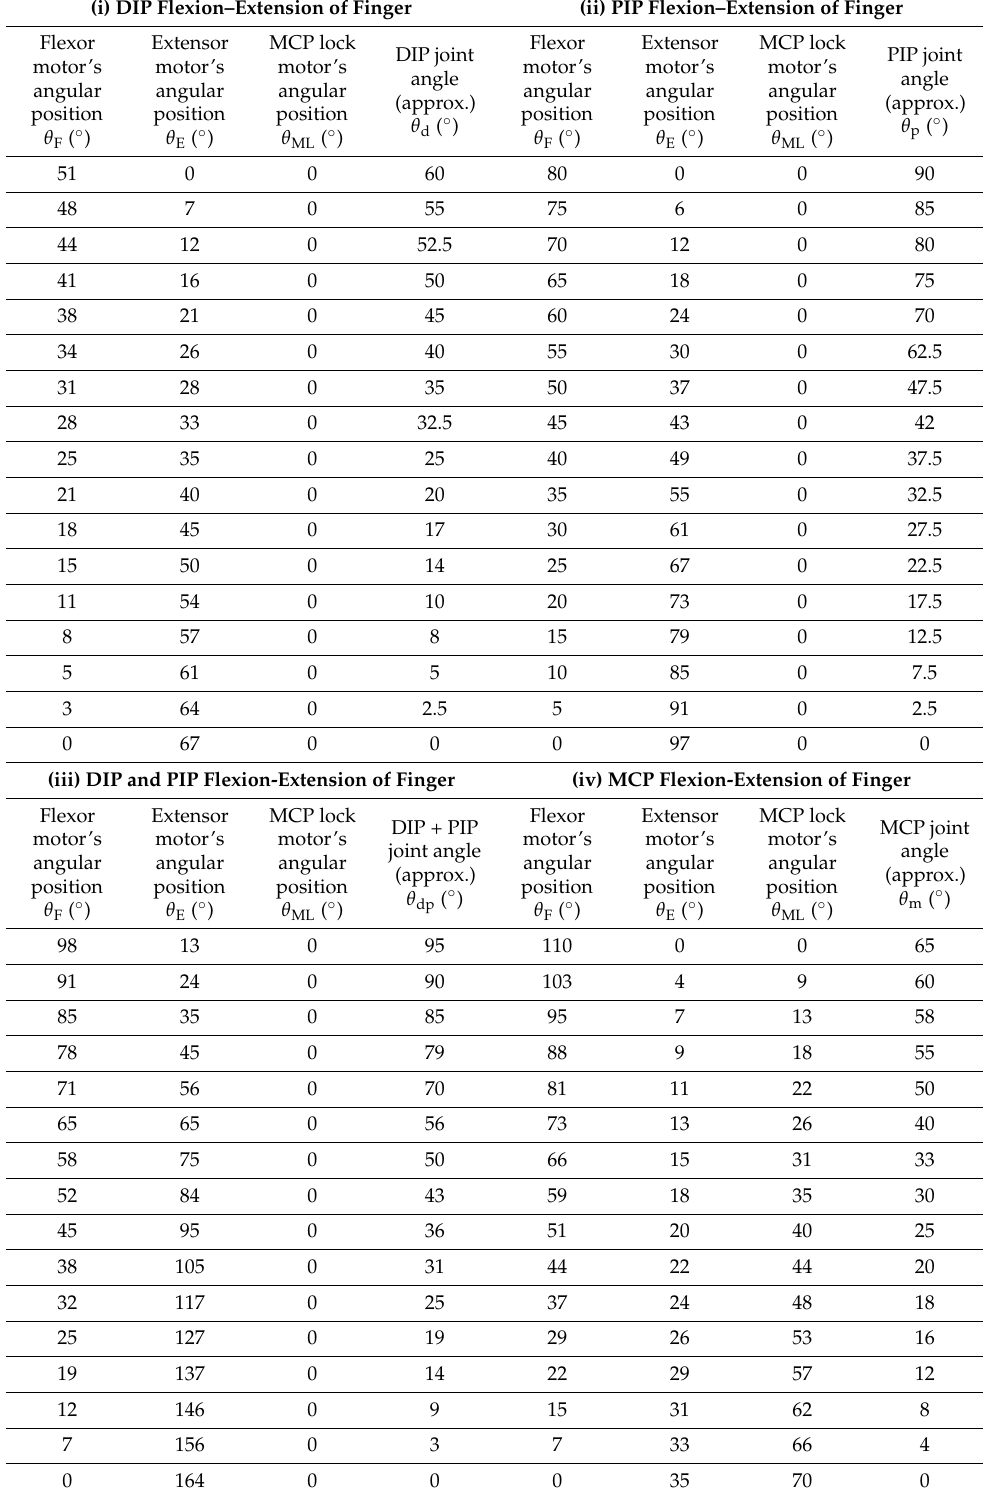
Table 4. Calibration chart for finger joint